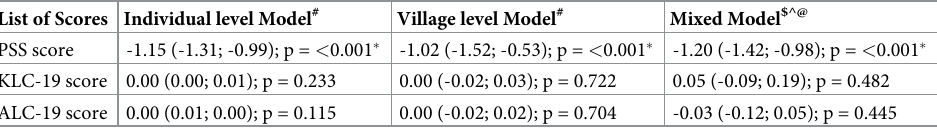
# Univariable linear regression models were applied. $ Mixed-effects linear regression modelling was used. ^ Models were adjusted for the age, level of education, monthly income and respective scores of the participants. @ Each model included individual family and village level random effects. � p-value < 0.05 considered as